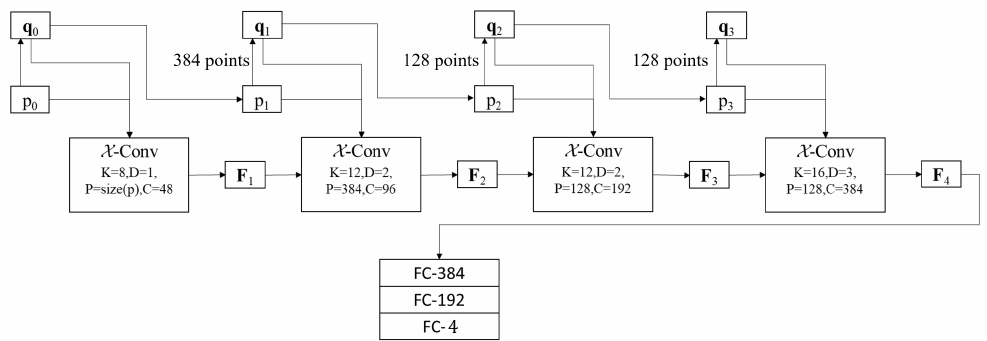
Figure 10. The PointCNN based on Ξ